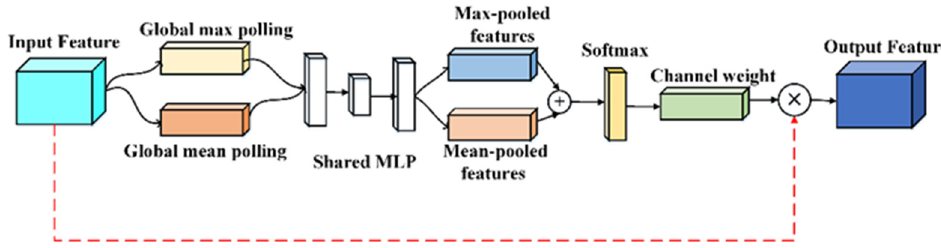
Figure 2. Architecture of the CAM